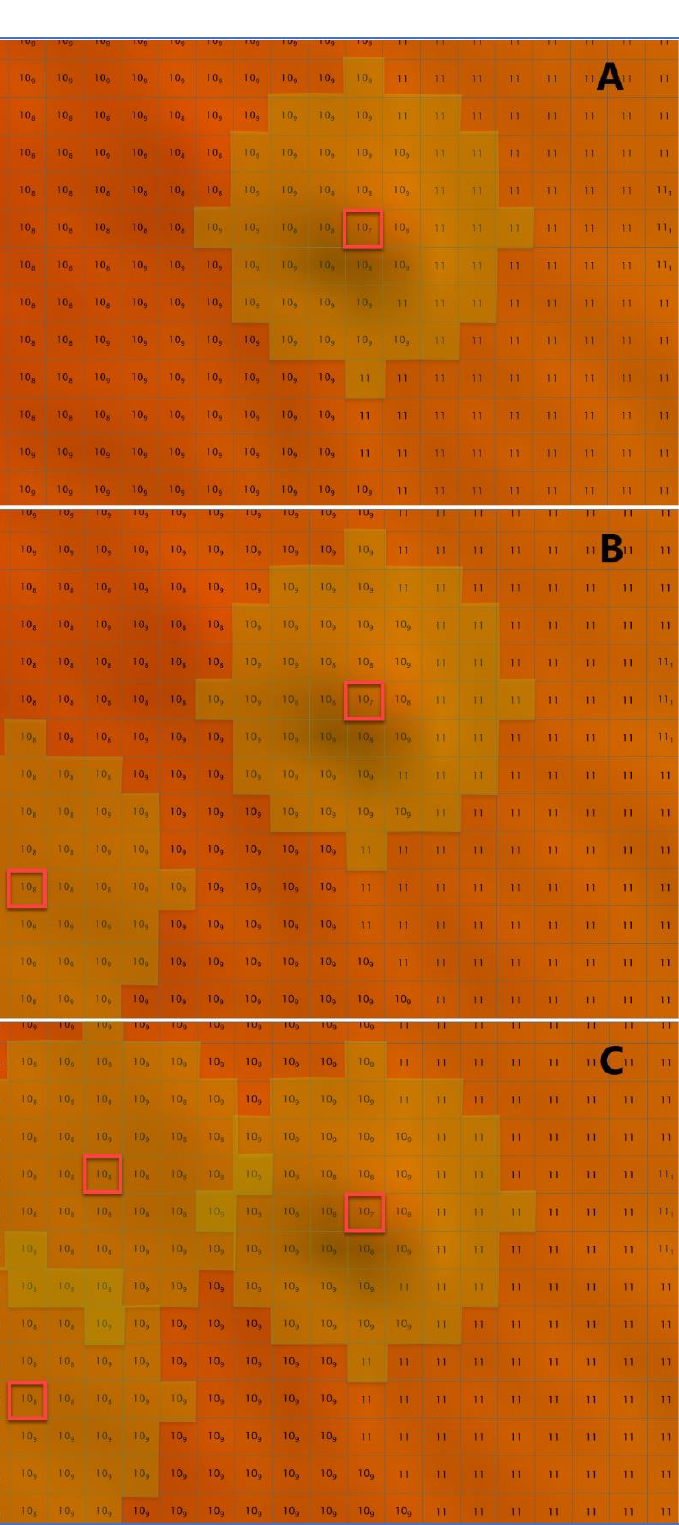
Figure 17. The Point Additive method used in the Sounding Selection tool. First, the shallowest sounding is selected, and the radius of soundings are removed ( A ). The next shallowest sounding is then chosen, radius removes neighboring soundings ( B ), and the process continues until all soundings are accounted for. The area of removed neighboring soundings can overlap, as in ( C ). The black values are depth values, in meters, from the evaluated grid; when shown, the sub-index represents